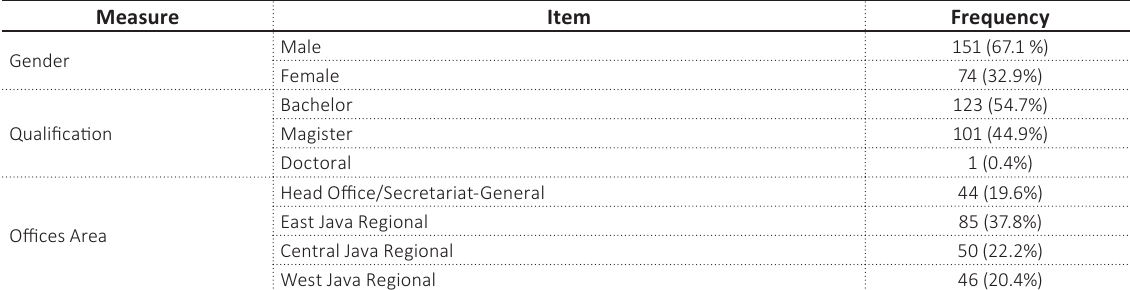
Table 2. Descriptive statistics of